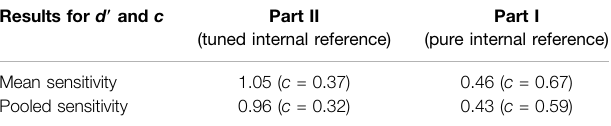
TABLE 4 | Estimated sensitivity d ′ and decision criterion c for both parts of the experiment. As expected, the sensitivity estimated for part I is considerably lower than for part II. For both parts, the decision criterion indicates a tendency towards the response “ real. ” In part I, this tendency is even stronger than in part II. Results for d 9 and